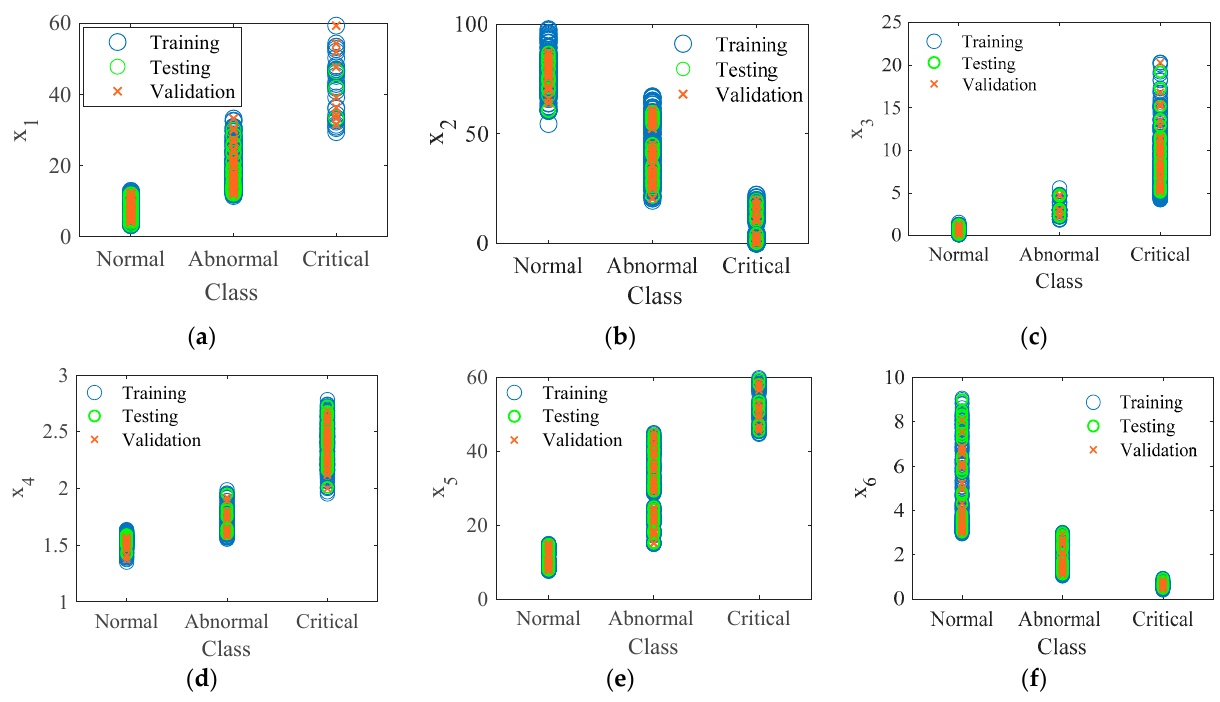
Figure 14. Visualization of the training samples of leakage current indicators: ( a ) x 1 ; ( b ) x 2 ; ( c ) x 3 ; ( d ) x 4 ; ( e ) x 5 ; ( f ) x 6 .